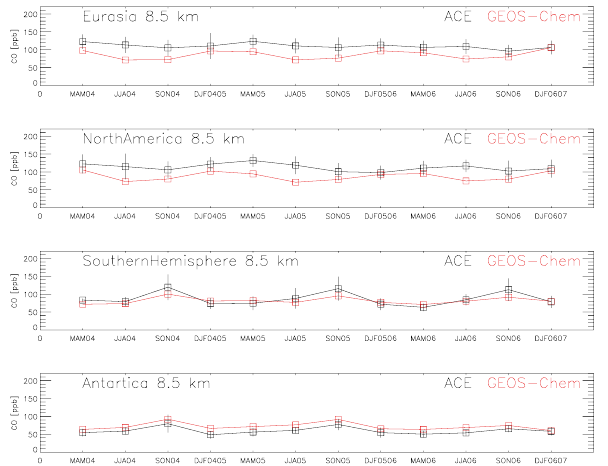
Fig. 12. Seasonal and hemispheric variations of CO volume mixing ratios observed (black) and simulated (red) averaged in different regions at 8.5km.